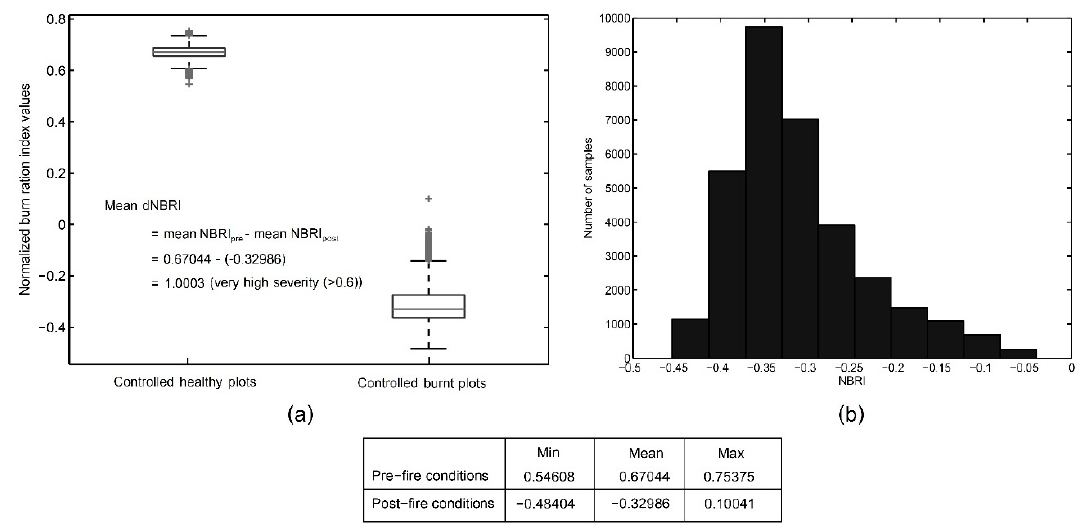
Figure 2. ( a ) The box plots of the burnt and unburnt NBRI of the training samples and the calculation of the mean dNBRI; ( b ) The histogram of NBRI distribution in the training burnt samples.